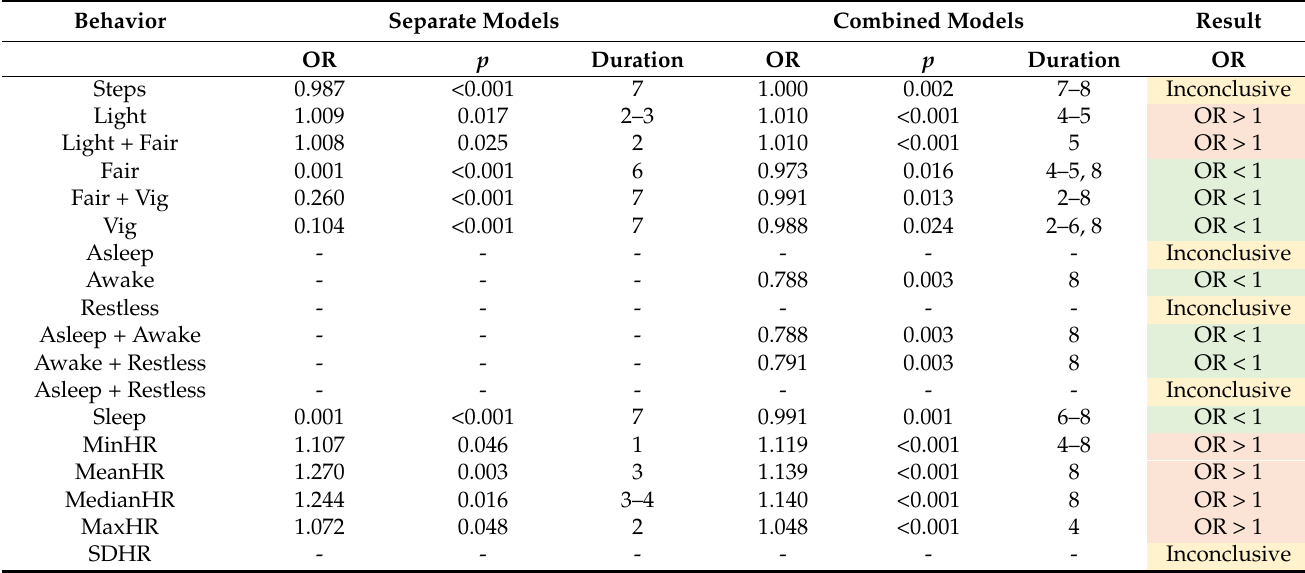
Table 5. Summary of results from the conditional logistic regression models: odd ratios for a unit increase in